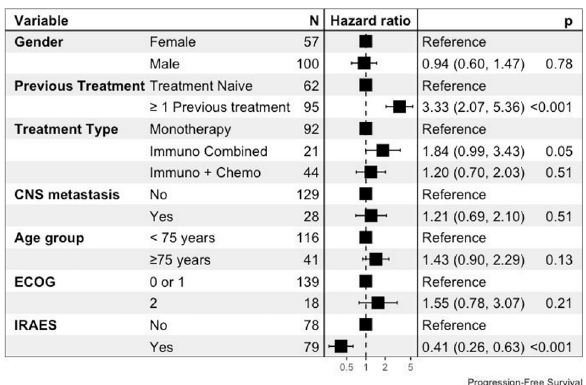
Figure 2. Kaplan-Meier estimates for overall survival.